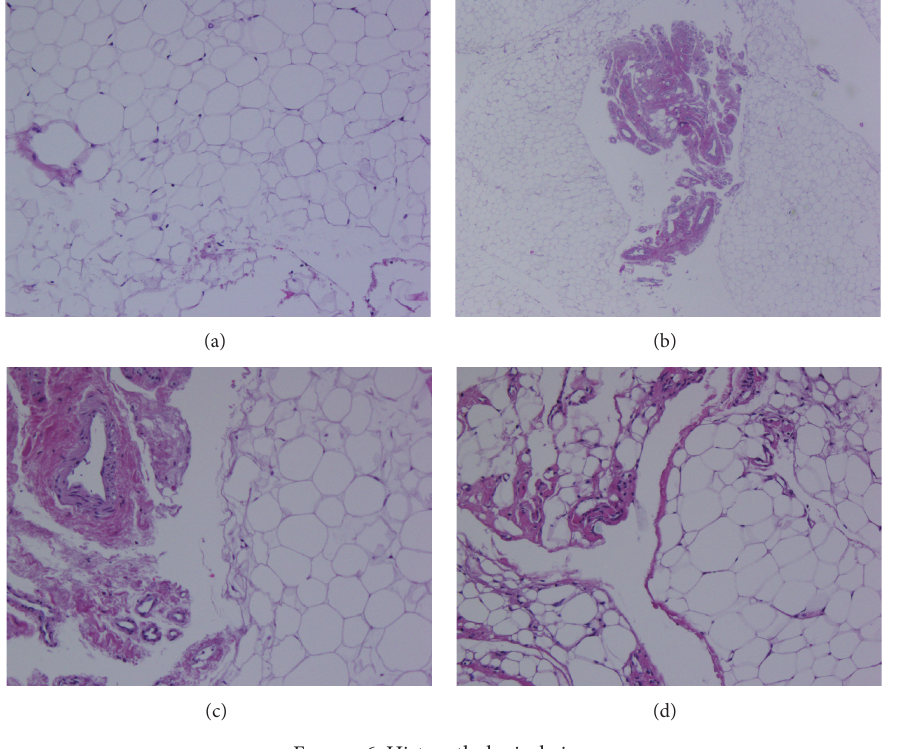
Figure 6: Histopathological